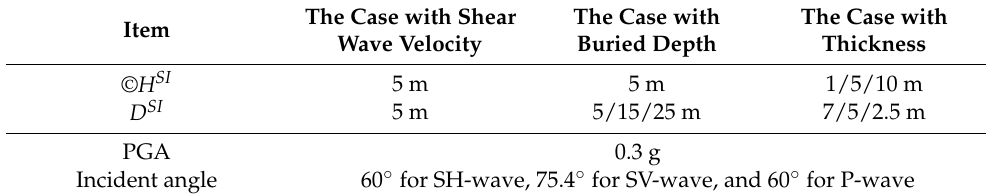
Table 1. Study cases performed in example 1. The Case with Shear The Case Item